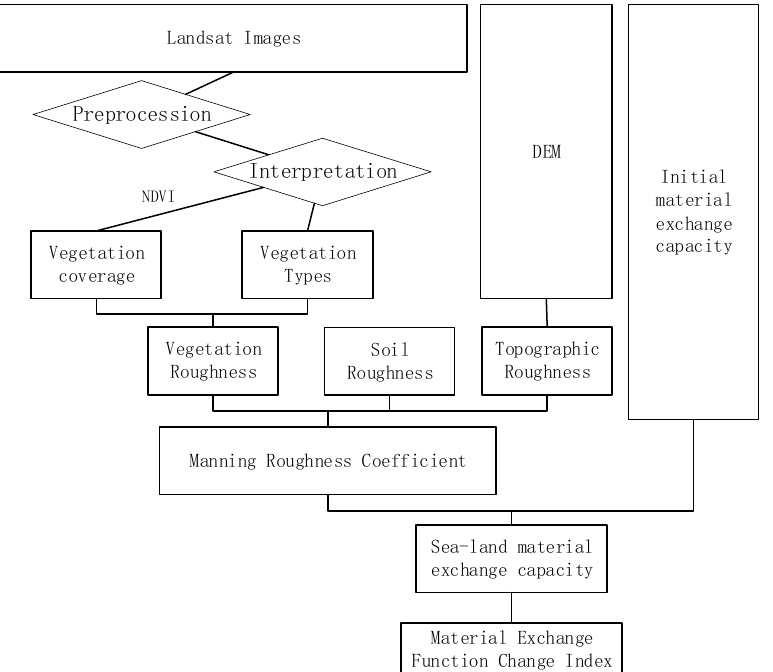
Figure 2. Conceptual model for evaluating the function of land–sea material exchange in the intertidal zone.